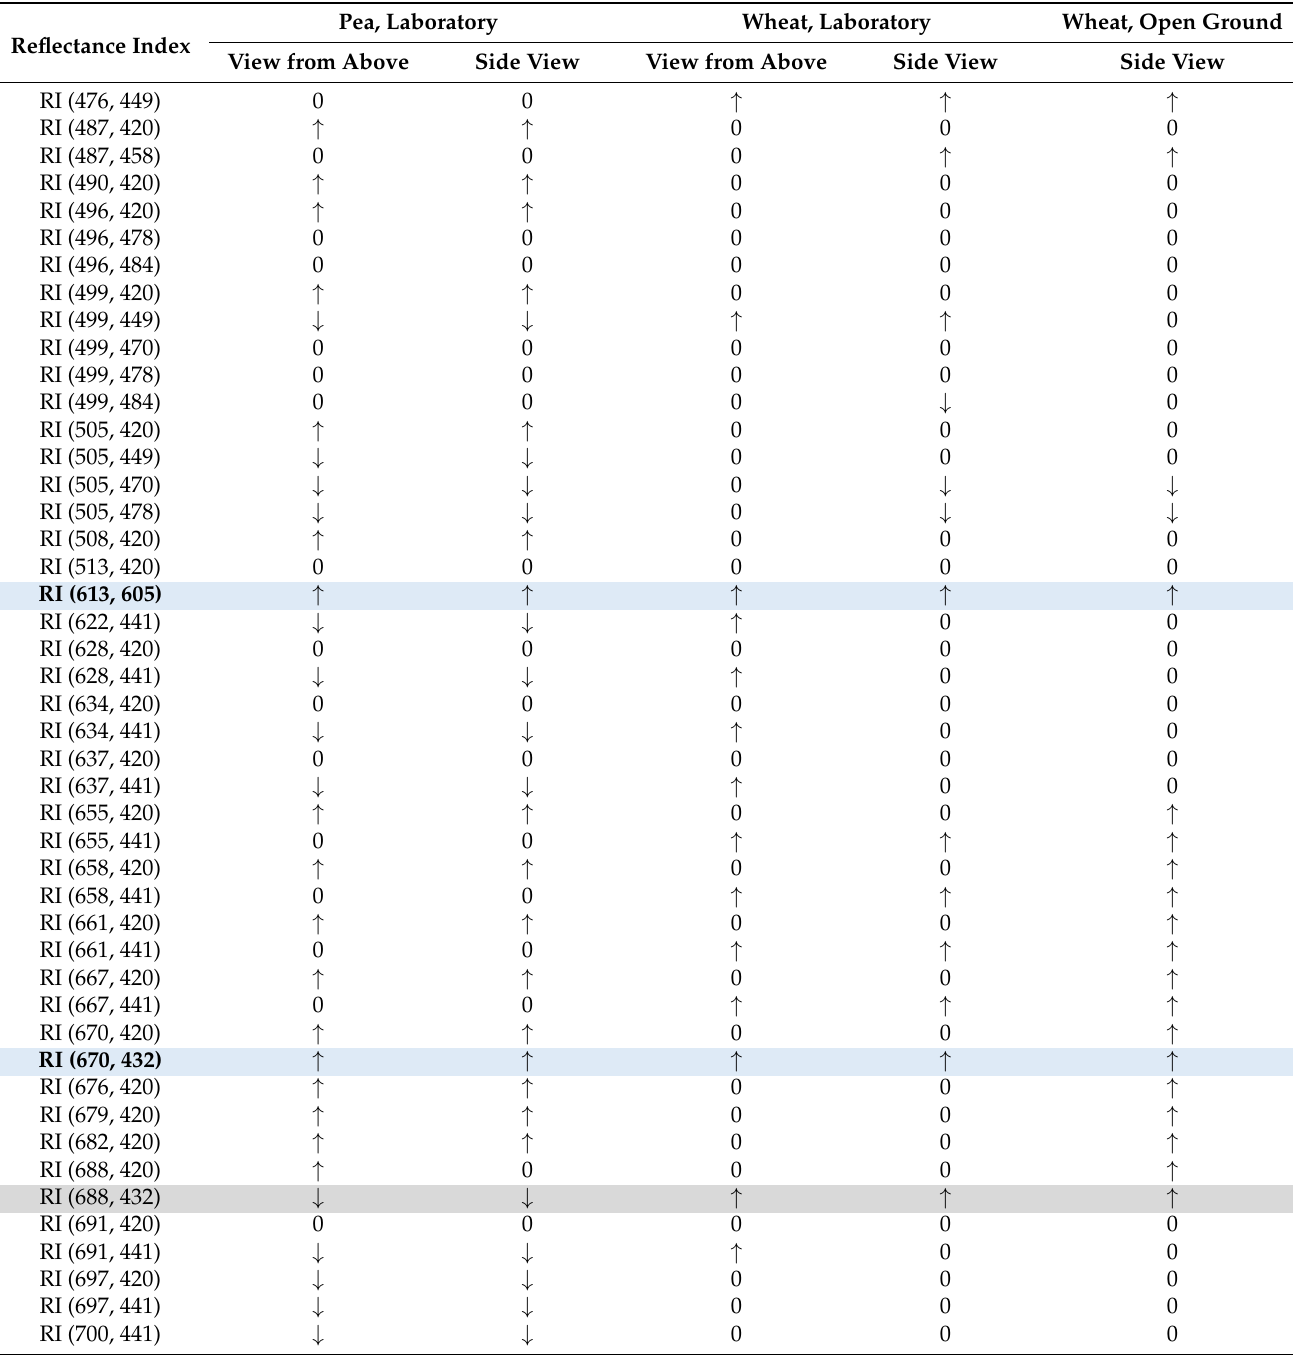
Table 1. The directions of drought-induced changes in 46 normalized reflectance indices. These RIs were revealed in our previous work [38]. ↑ —RI in plants under soil drought was significantly increased ( p < 0.05) in comparison to control plants with irrigation; ↓ —RI in plants under soil drought was significantly decreased in comparison to control plants; 0—significant changes in RI in plants under soil drought in comparison to control plants was not observed. Terms “view from above” and “side view” showed results of hyperspectral measurements at 90 ◦ and 45 ◦ angles to the ground plane, respectively. RIs which were significantly increased under the soil drought in all variants of experiments are marked by blue, while RIs which were significantly changed (with different direction of these changes) under the soil drought in all variants of experiments are marked by